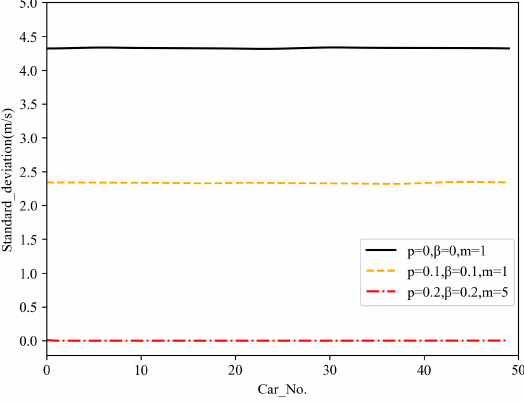
Figure 5. Standard deviation of the velocity of each car simulated with various parameter values.